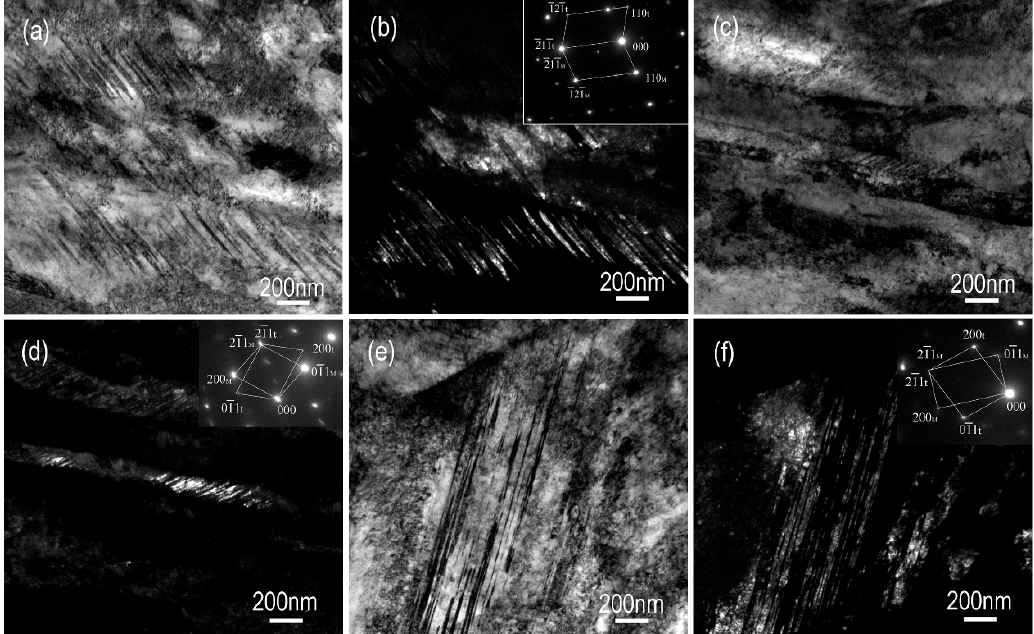
Figure 10. Transmission electron microscope (TEM) images of the deformed Q-P-T steels at various temperatures: ( a ) 25 °C, ( c ) 200 °C and ( e ) 350 °C, BF images; ( b ) 25 °C, ( d ) 200 °C and ( f ) 350 °C, DF images and the corresponding SAED pattern of twin-type martensite.